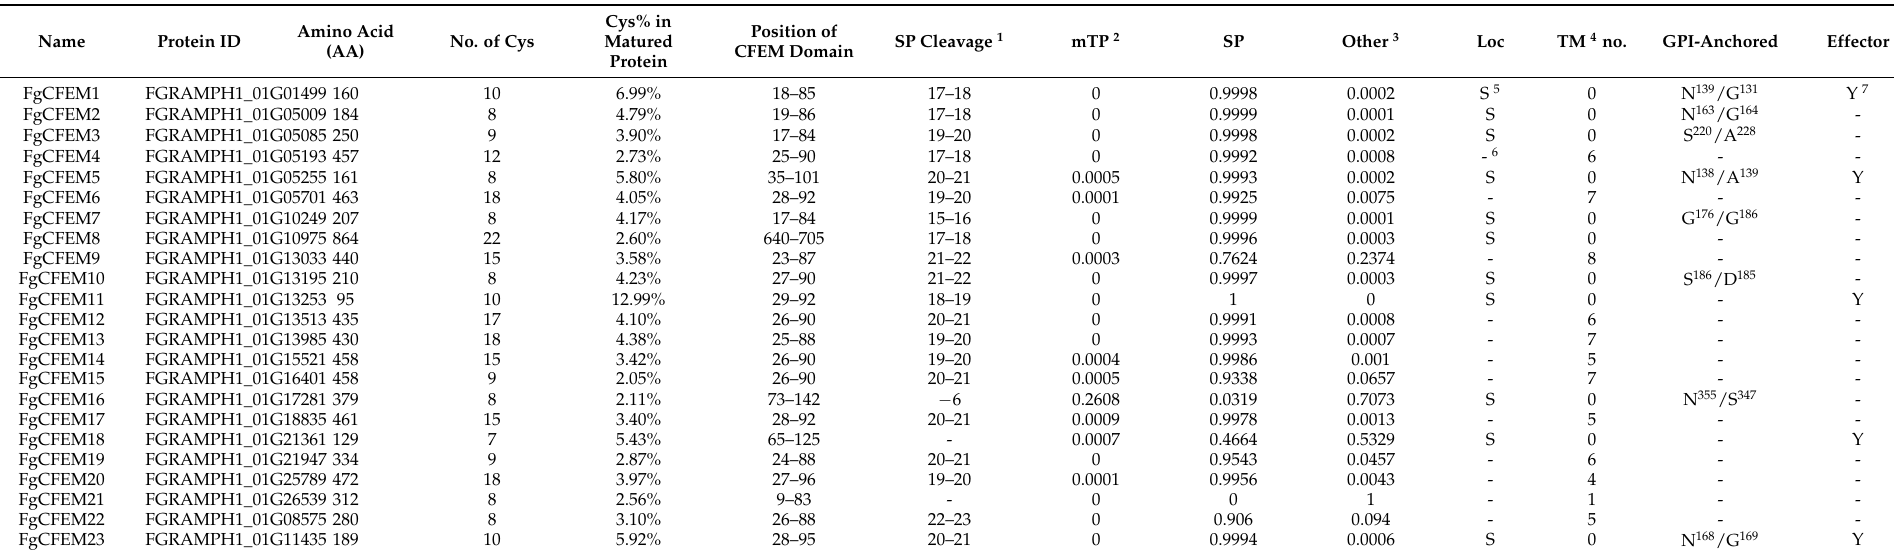
Table 1. The identification of Common in Fungal Extracellular Membrane (CFEM) proteins repertoire in F. graminearum